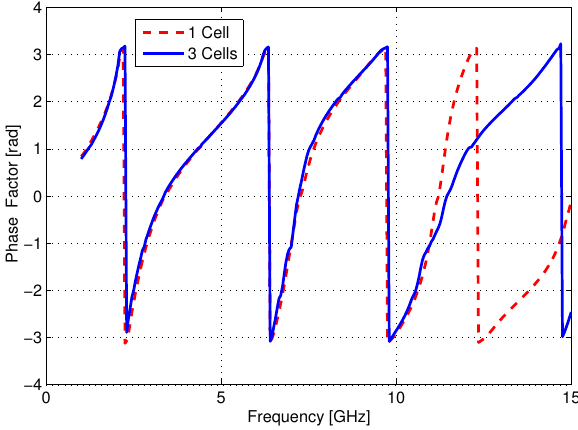
Figure 6: | S 11 | of the three-cell structure with different cell lengths.